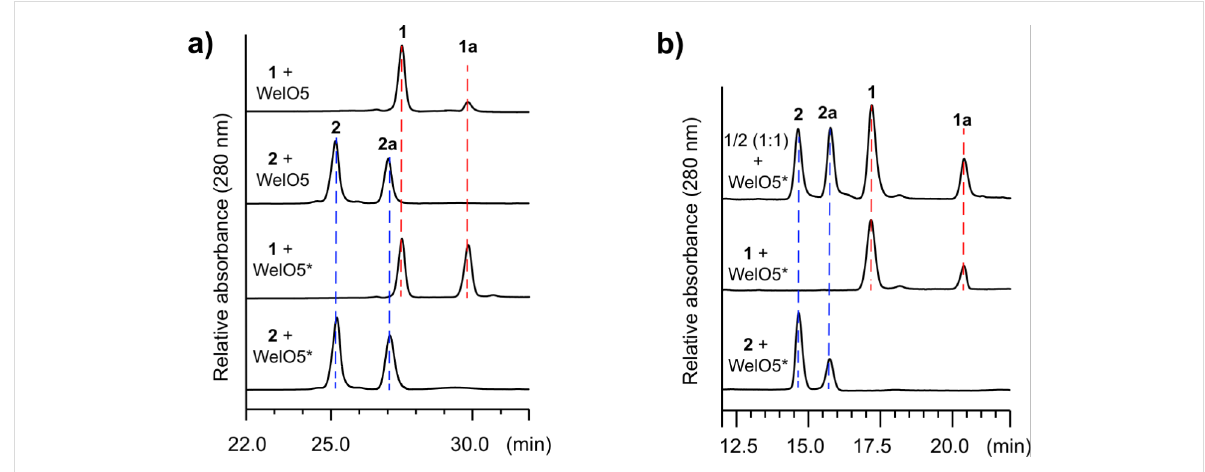
Figure 2: a) In vitro characterizations show that WelO5* has comparable activity to both 1 and 2 , distinct from WelO5. b) In vitro characterization of WelO5* substrate preference towards 1 and 2 using a substrate competition assay. For the HPLC data shown in a), assays were conducted with WelO5* or WelO5 (20 µM) with 0.5 mM of 1 or 2 for 20 min at 30 °C. HPLC was run with a C18 Luna column (Phenomenex 250 × 4.6 mm) with a sol- vent gradient from 60–90% methanol/water in 30 min at a flow rate 1 mL/min. For the HPLC data shown in b), assays were conducted with WelO5* (20 µM) with 0.5 mM of 1 and/or 2 for 10 min at 30 °C. HPLC was run with a XC-C18 Kinetex column (Phenomenex 150 × 2.6 mm) with an isocratic solvent 50% acetonitrile/water in 30 min at a flow rate 0.4 mL/min. These conditions were chosen to achieve a better separation of 1 / 1a / 2 / 2a .